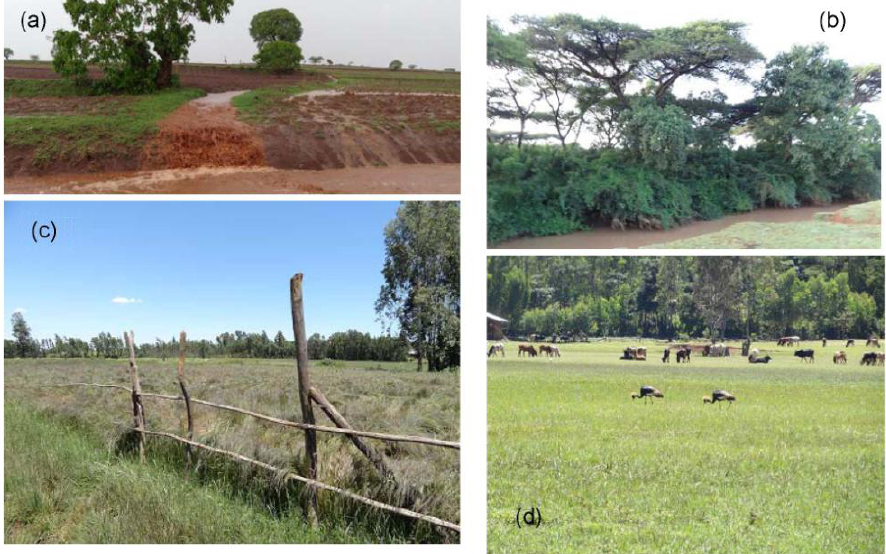
Figure 3. Sediment laden runoff from ploughed fields in the Koga watershed during a rainfall event ( a ), remaining natural woody vegetation along the Koga river ( b ), small crop farm plots and homestead eucalyptus trees ( c ), pasture land and eucalyptus tree plantations ( d